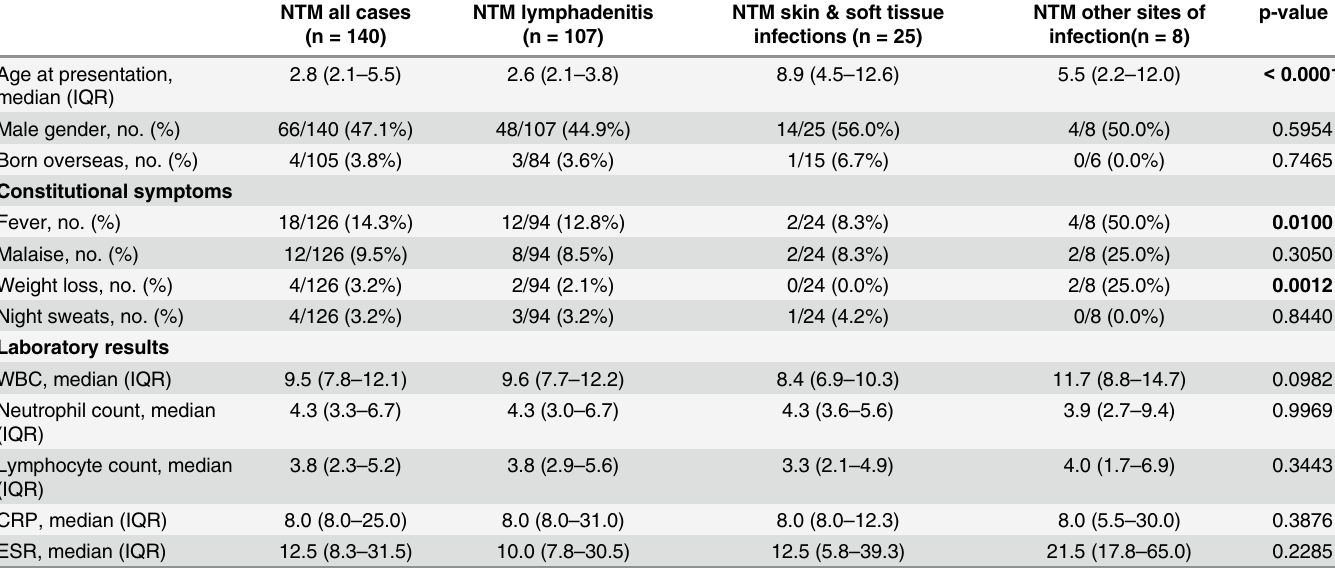
Table 1. Demographic characteristics, symptoms, and laboratory findings at presentation in the three groups with nontuberculous mycobacterial